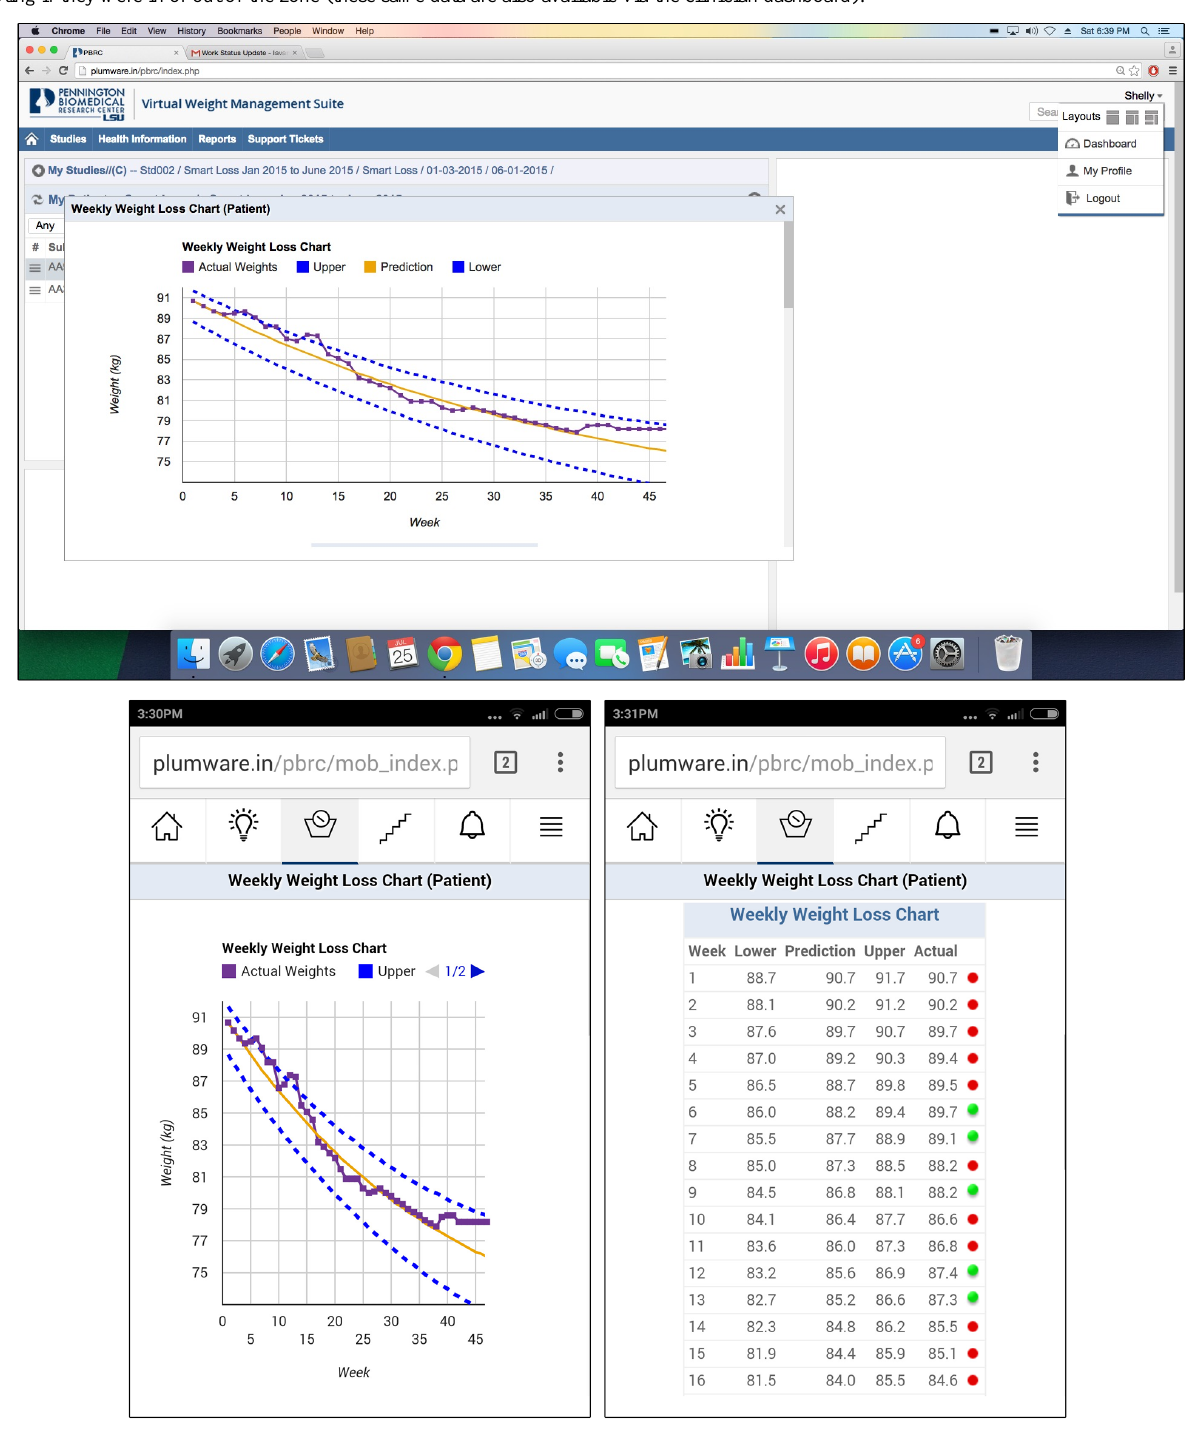
Figure 2. Panel A: A screenshot from the clinician dashboard for a hypothetical client. The SmartLoss intervention generates a SmartGraph that shows the predicted course of weight change for an individual assuming adherence to the energy intake target (yellow line), which can be either an increase or decrease in daily energy intake. The upper and lower bounds around the predicted weights (dashed blue lines) create a “weight zone” or “zone of adherence” and participants are considered adherent if their body weight (purple line) falls within the zone over time. Also, intervention strategies are delivered based on the participant’s actual weight in relation to this zone, and the graph is available to participants and health care or research professionals at any time via the clinician dashboard and app. Panel B: The SmartGraph is automatically delivered to participants smartphones at regular intervals (e.g., once per day, after a new body weight is received by the dashboard). Panel C: A “details view” in the app allows participants to see their weights over time in addition to their predicted weights, the weights associated with the upper and lower bounds of the adherence zone, and a color coded flag denoting if they were in or out of the zone (these same data are also available via the clinician